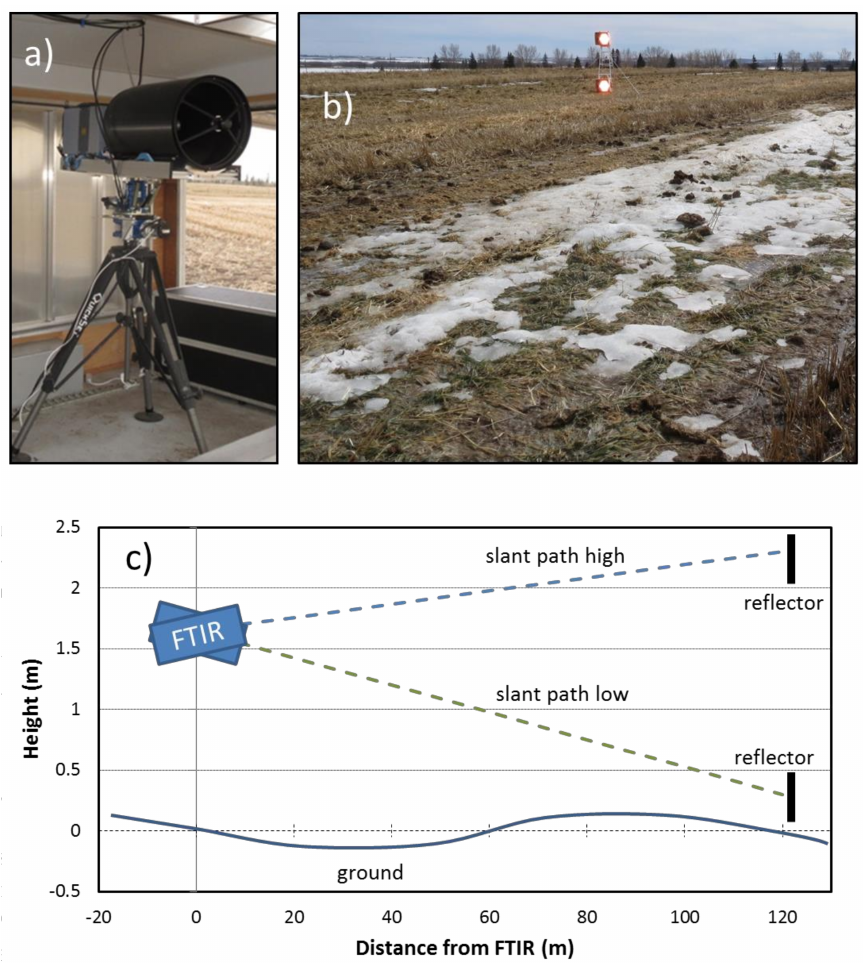
Figure 2. The OP-FTIR system: ( a ) sensor and aiming motors (in trailer); ( b ) winter-grazing (WG) field site showing high and low OP-FTIR reflectors; ( c ) idealized drawing of the system; The WG site in ( b ) was photographed on a day having near-maximum N 2 O